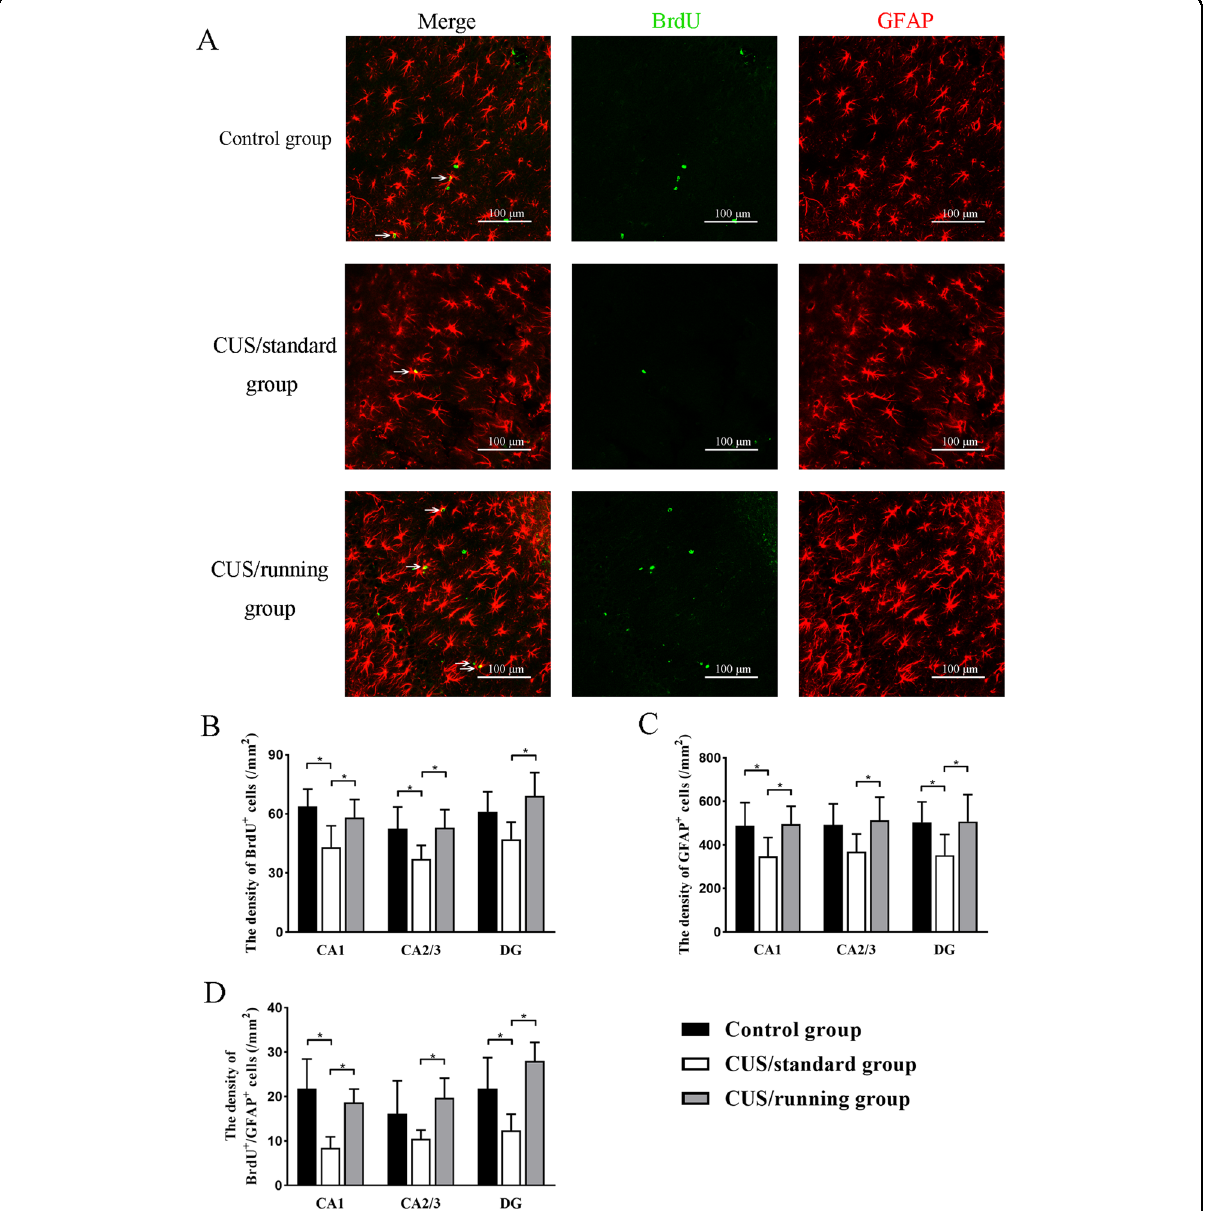
Fig. 5 The positive effects of running exercise on the newborn astrocytes in the hippocampus of CUS rats. A Representative pictures of immuno fl uorescence staining with an anti-BrdU antibody and an anti-GFAP antibody in the hippocampus in the control group, CUS/standard group and the CUS/running group. Bar = 100 μ m. B Quanti fi cation of BrdU + cells in the three subregions of the hippocampus for the three groups of rats ( n = 5 per group, mean ± SD). C Quanti fi cation of GFAP + cells in the three subregions of the hippocampus for the three groups of rats ( n = 5 per group, mean ± SD). D Quanti fi cation of BrdU + /GFAP + cells in the three subregions of the hippocampus for the three groups of rats ( n = 5 per group, mean ± SD). Asterisk indicates p < 0.05. CUS chronic unpredictable stress, GFAP glial fi brillary acidic protein, BrdU